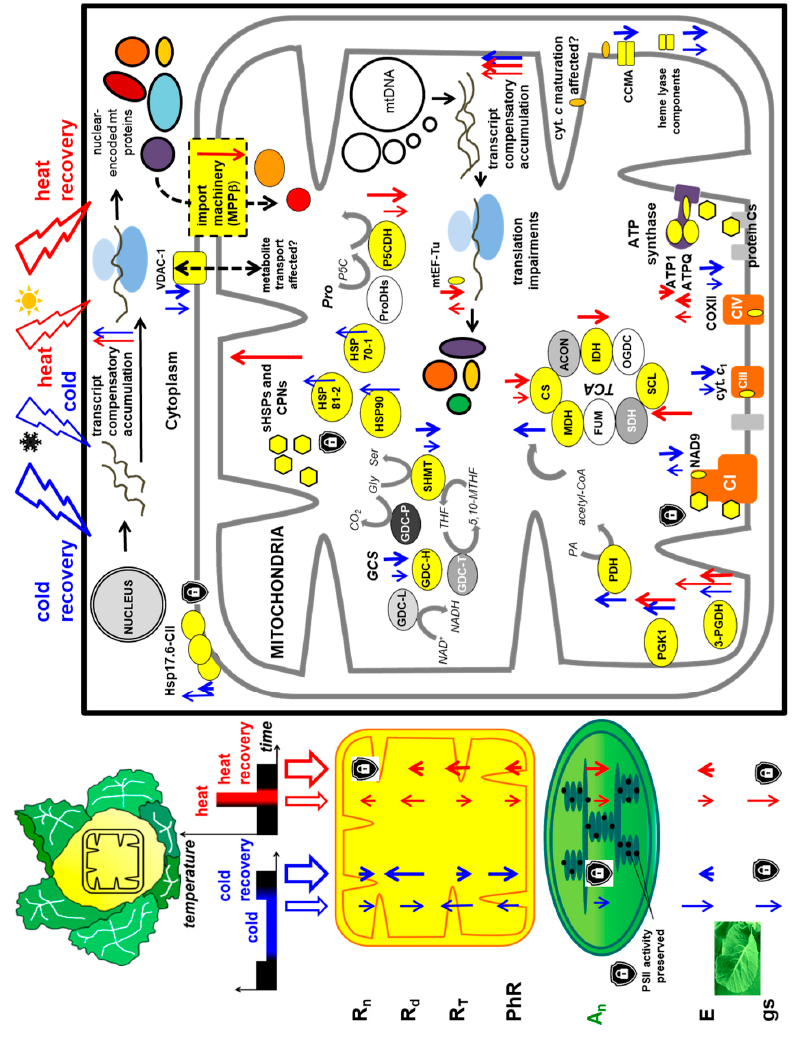
Figure 8. Proposed model of the impact of temperature stress and recovery on mitochondrial biogenesis in cauliflower curds. Investigated phenomena are depicted. Regulations in the cold and heat are shown by thin blue and red arrows; regulations in stress recovery by the respective thick blue and red arrows. Up-regulations and down-regulations are denoted by arrow heads raised up and down, respectively. Icons with a shield inside depict sustained physiological parameters or phenomena ( left ) or protective function of selected proteins in mitochondrial biogenesis ( right ). Left panel: stress dosage scheme and regulations in key physiological parameters. Right panel: Proteins and complex subunits regulated by abundance are yellow-marked. Some regulatory steps affected by stress conditions are highlighted by discontinuous lines and arrows. Important abbreviations: A, net photosynthetic rate; ATP1, ATPQ, ATP synthase subunits 1 and d; CCM, cytochrome c maturation; CPN, chaperonin; C(s), complex(es); COX, cytochrome c oxidase; CS, citrate synthase; cyt. c , cytochrome c ; E, leaf transpiration; GCS, glycine cleavage system; GDC, glycine decarboxylase; gs, stomatal conductance; HSP(s), heat shock protein(s); IDH, isocitrate dehydrogenase; MDH, malate dehydrogenase; MPP, mitochondrial processing peptidase; mt, mitochondrial; NAD9, complex I subunit 9; P5CDH, 1- Δ -pyrroline-5-carboxylate (dehydrogenase); PDH, pyruvate dehydrogenase; 3-PGDH, 3-phosphoglycerate dehydrogenase; PGK1, phosphoglycerate kinase isoform 1; PhR, photorespiration; ProDH(s), proline dehydrogenase(s); R d , light respiration; R n , dark respiration; R T , total light respiration; SCL, succinyl-CoA ligase; SHMT, serine hydroxymethyltransferase; TCA, tricarboxylic acid; VDAC, voltage-dependent anion channel. Further data in the text.